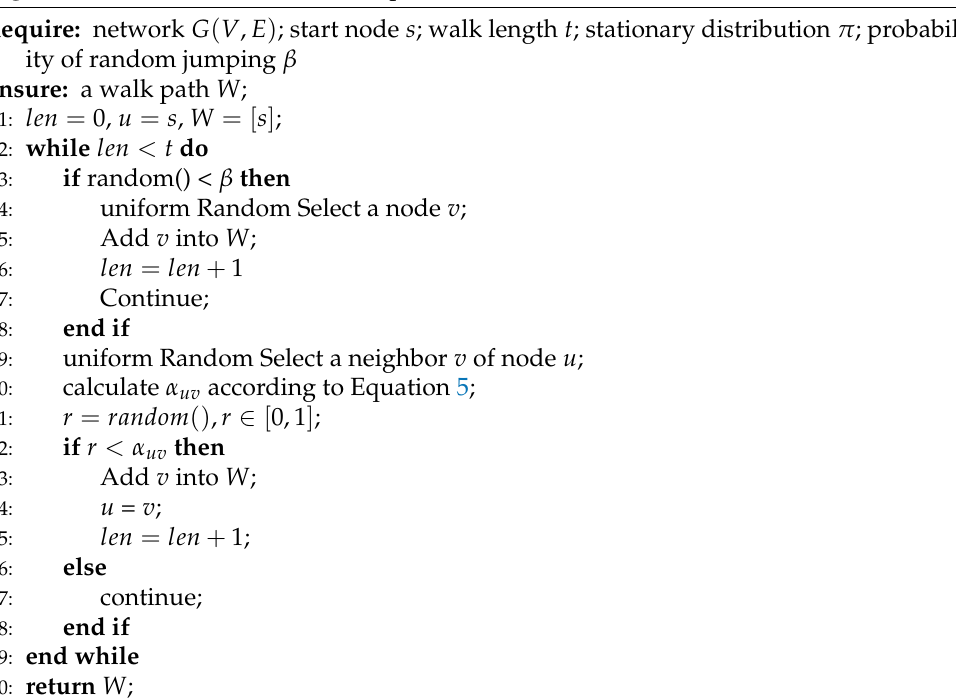
Algorithm 2 PAW: Probabilistic Accepted